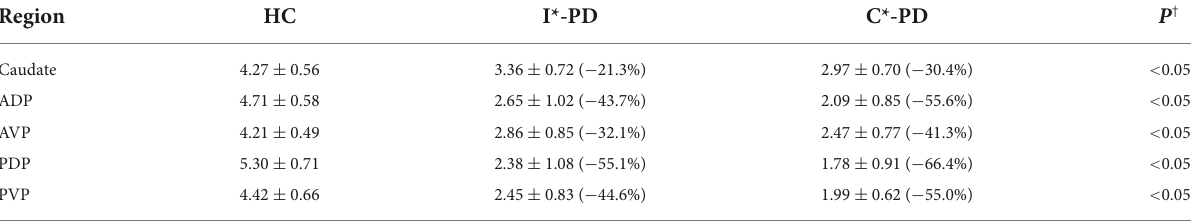
TABLE 2 Comparison of striatal subregional SUVRs in the PET/MR cohort.